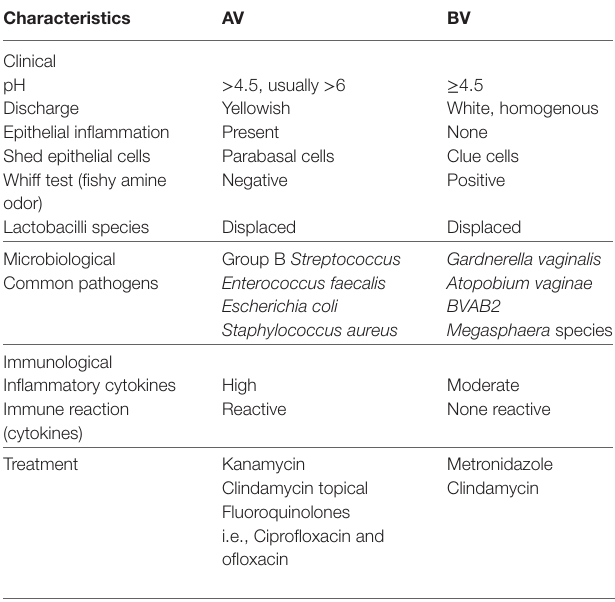
TABLe 1 | Comparison of clinical and microbiological characteristics of aerobic vaginitis (AV) and bacterial vaginosis (BV). Characteristics